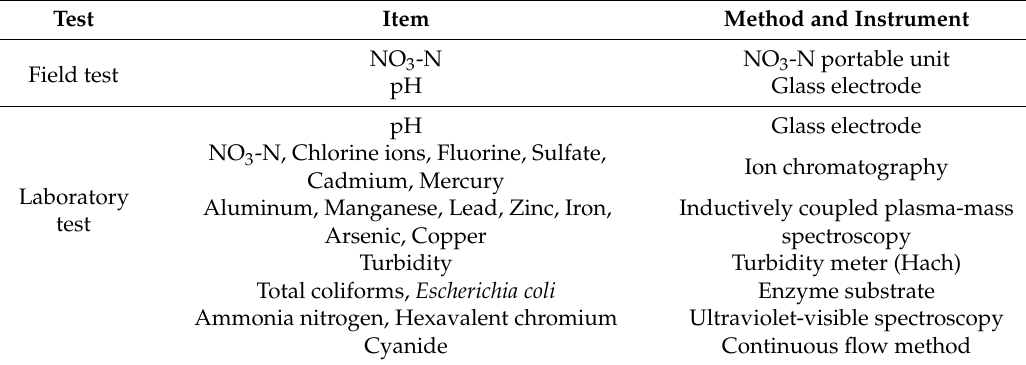
Table 3. Items and methods of groundwater quality tests.